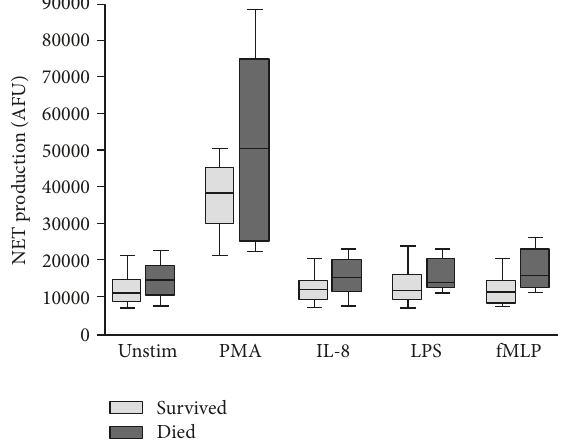
Figure 5: Box-and-Whisker plot (10th–90th percentile) of NET production in patients who survived ( 𝑛 = 39 ) versus those who died ( 𝑛 = 5 ) in response to no stimulant (Unstim), PMA, IL-8, LPS, and fMLP.